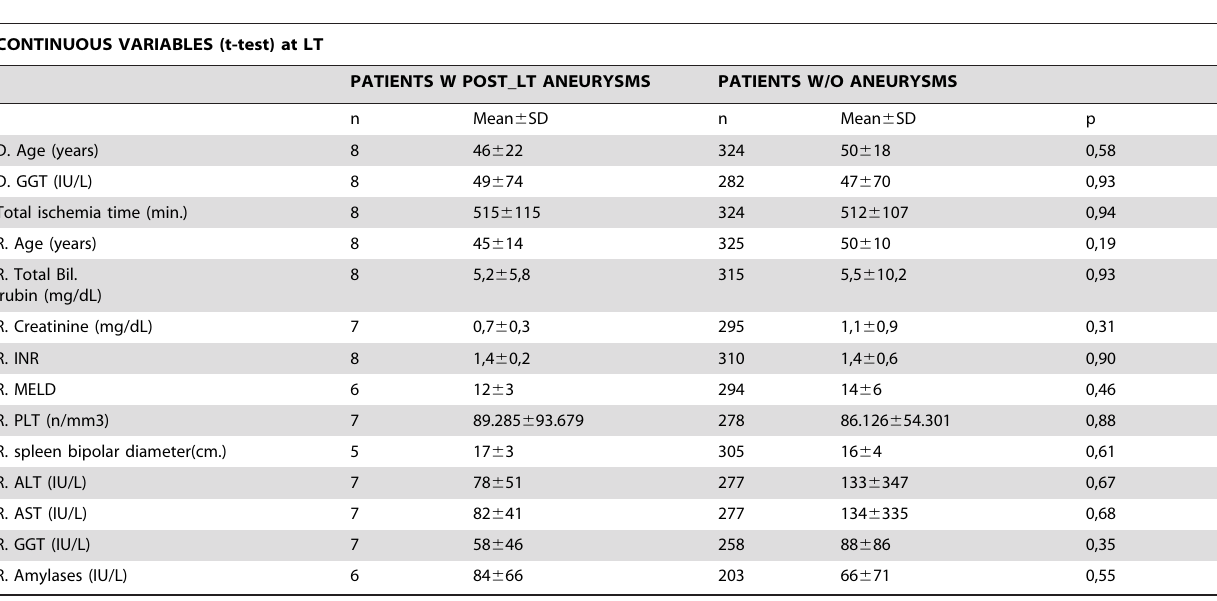
Table 4. Univariate analysis of continuous variables (just before LT) of transplanted patients, according to the presence of post-LT visceral